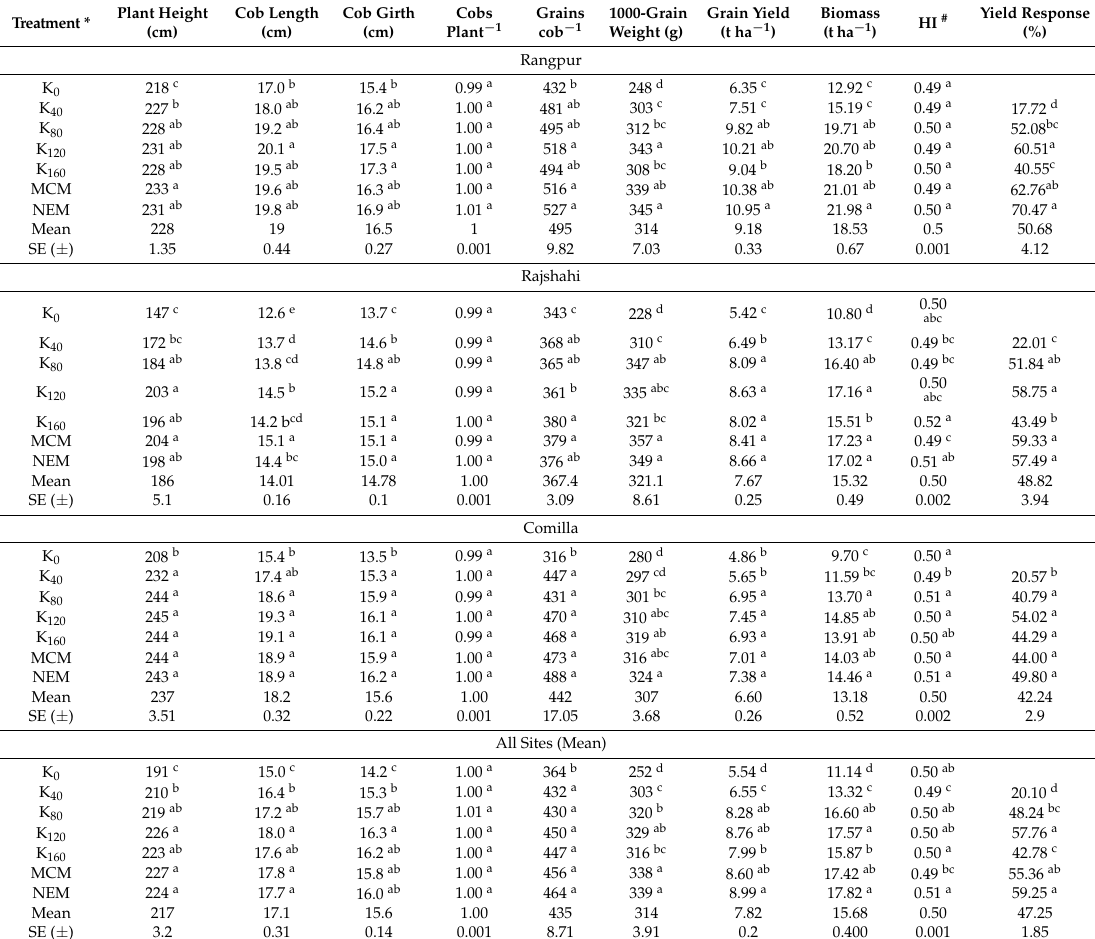
Table 5. Effect of K fertilization on growth, and yield and yield attributes of rabi maize in three field experimental sites in Bangladesh,